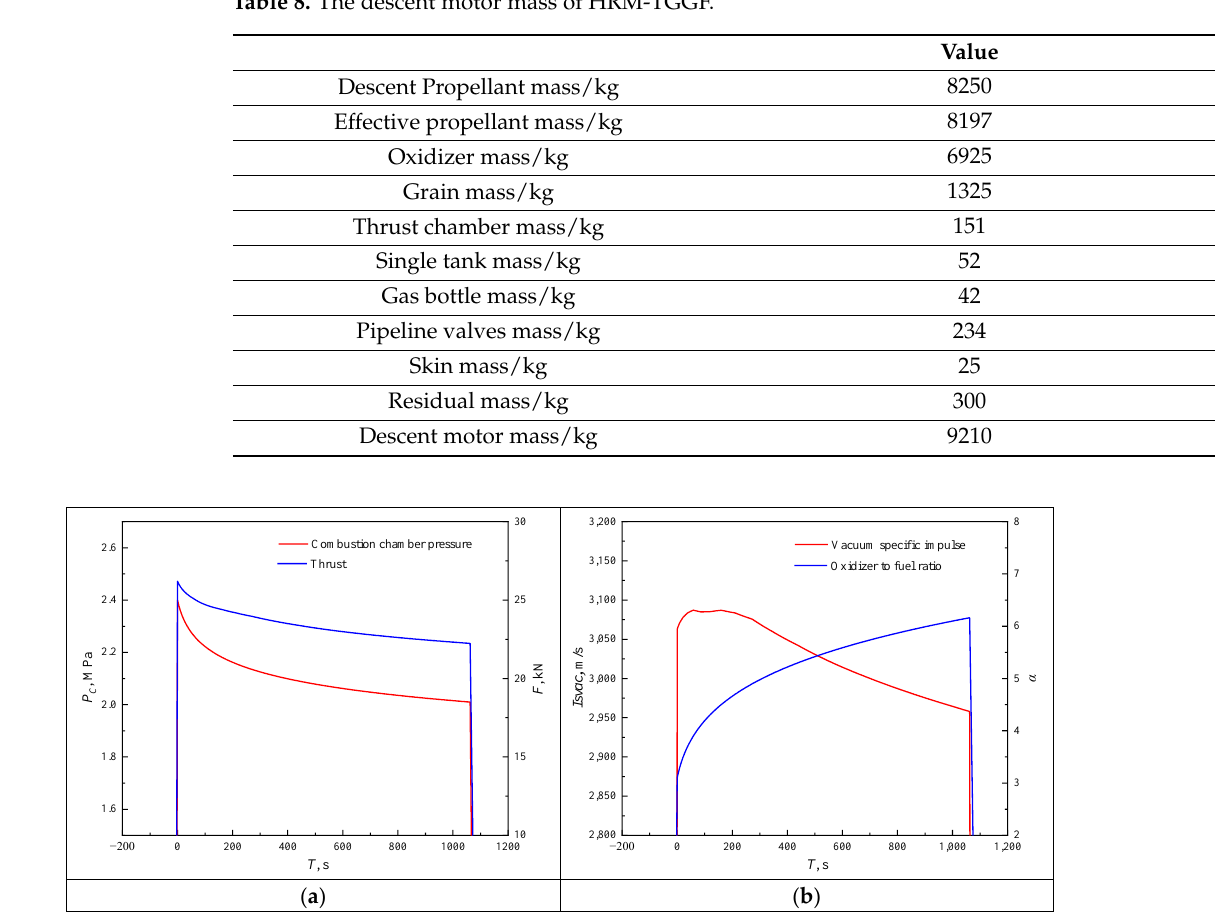
Figure 15. Internal ballistic simulation results for HRM-TGGF. ( a ) P c - T and F - T ; ( b ) I svac - T and α - T . Table 8. The descent motor mass of HRM-TGGF.